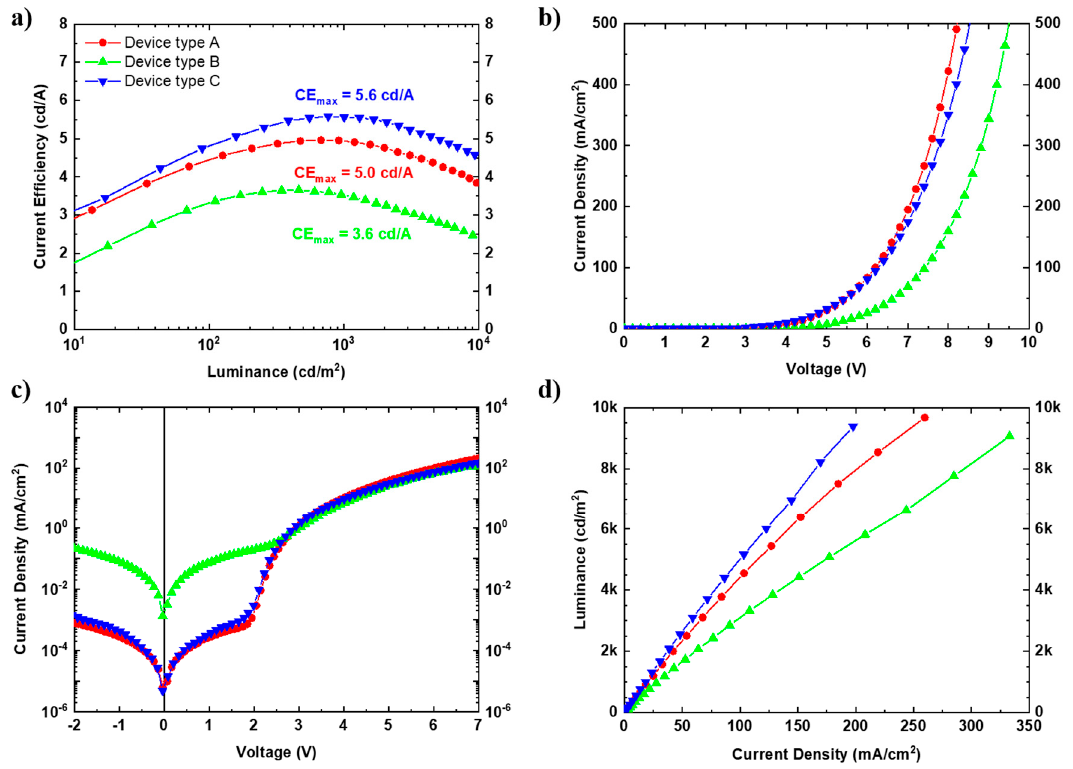
Figure 4. Electroluminescent performance of the different types of OLEDs devices, ( a ) current efficiency (J) as a function of luminance (L), ( b ) current density–voltage (JV) characteristics, ( c ) semi- log (JV) leakage current characteristics, and ( d ) luminance-current density (LJ) characteristics. Table 1. Statistical analysis of the performance of OLED devices using different hole injection electrodes. Statistic sample size of 8 different devices were used to present average values, together with standard deviation, and maximum values in brackets.